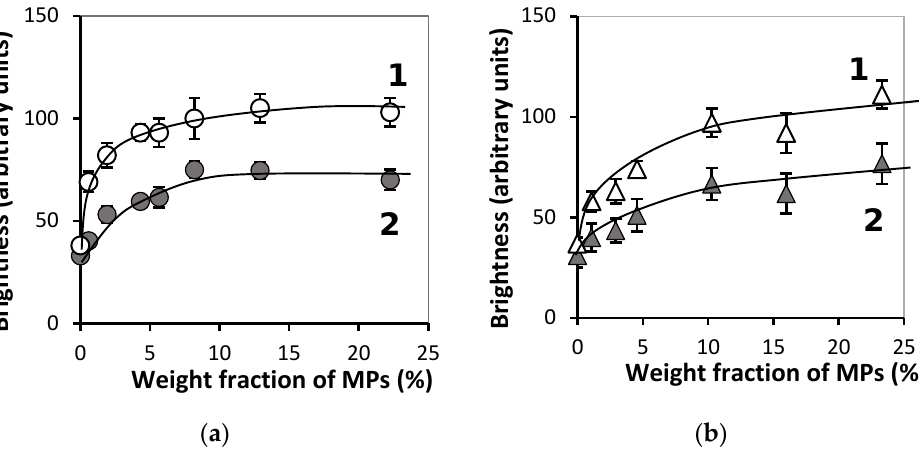
Figure 10. Dependences of maximal (1) and average brightness (2) at gel bulk on the MPs concen- tration for samples PAAm/Xanthan ( a ) and PAAm/Guar ( b ). Vertical bars reflect the confidence interval with p = 0.01.